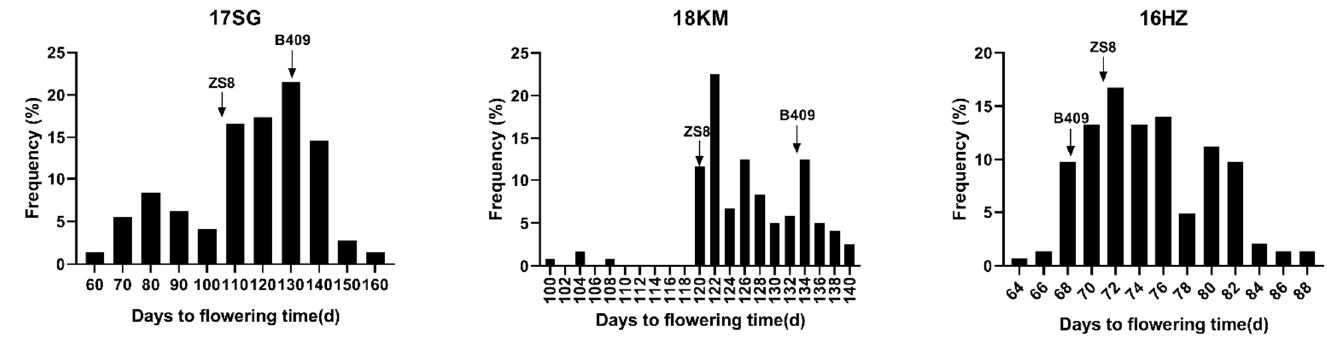
Figure 1. Double haploid (DH) population frequency distribution of flowering-time data in three environments. 17 SG: Shaoguan in 2016–2017; 18 KM: Kunming in 2017–2018; and 16 HZ: Hezheng in 2016. B409: female parent Bing409; ZS8: male parent Zhongshuang8hao. Black arrows represent average flowering time of parents in each environment.